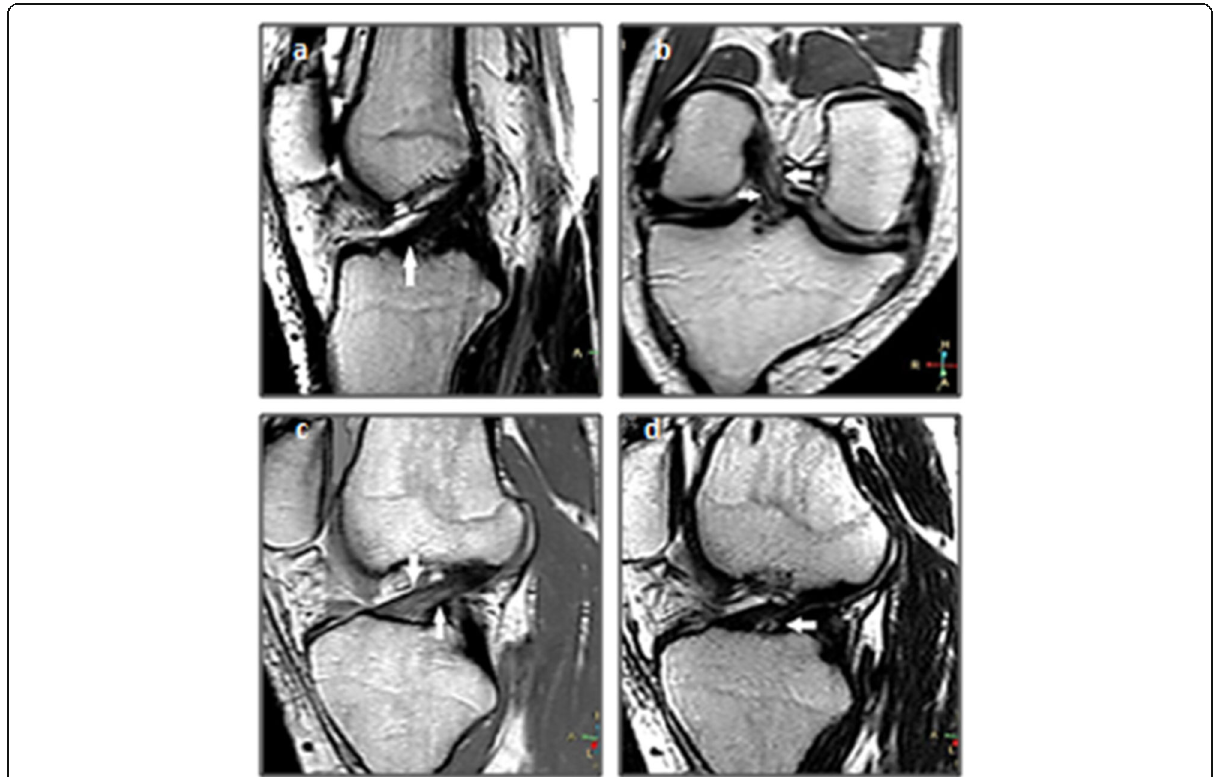
Fig. 3 A male patient, 22 years old, who suffered from twisting knee injury while playing football. a Sagittal T2 image revealed an intact ACL (white arrows). b Oblique coronal T2 and c , d oblique sagittal T2 MRI of right knee showing intraligamentous areas of intermediate signal intensity along the distal and mid-substance of the ACL (white arrows), but with some fibers still intact which are compatible with partial tear of the